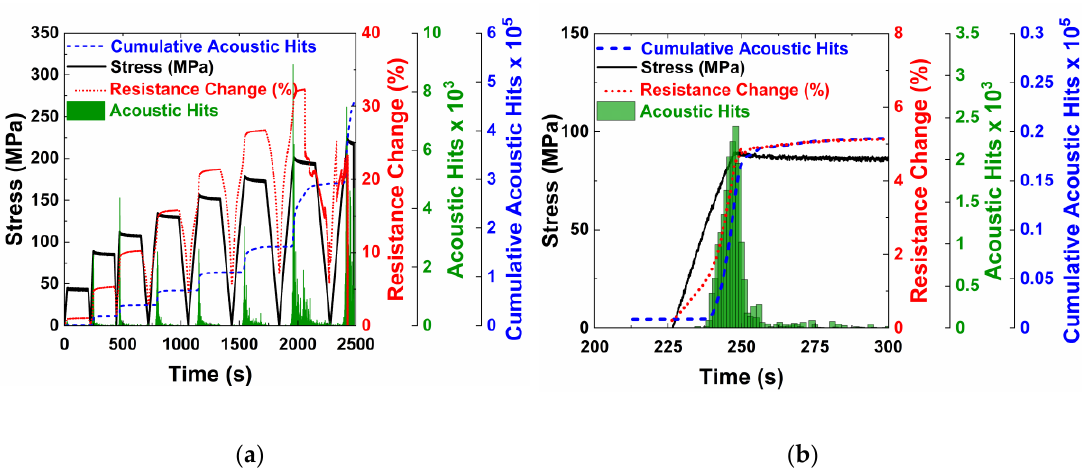
Figure 8. A specimen with carbon nanotubes under progressively increasing cyclic loading. ( a ) Stress, acoustic activity and electrical resistance throughout the cyclic test, and ( b ) an examination of the second loading cycle and the resistive response to the damage.